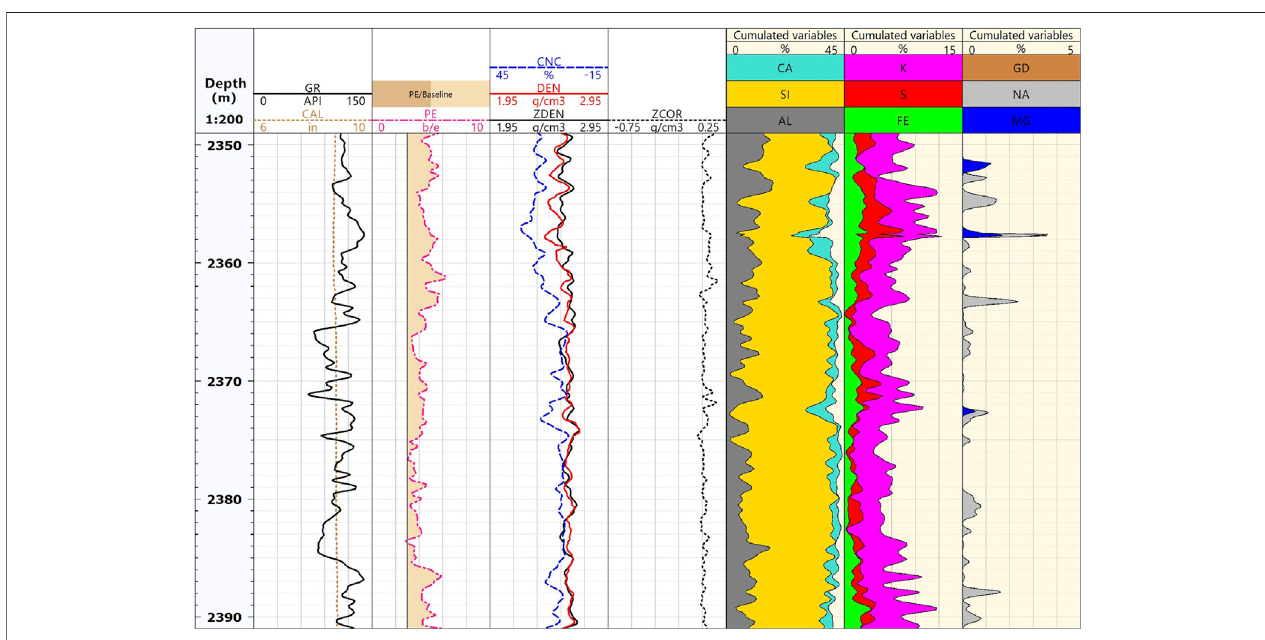
FIGURE 14 | Density comparison in a sand-shaly interval. The neutron-gamma density measurements (track 3, red) and conventional gamma density measurements (black) are highly consistent.